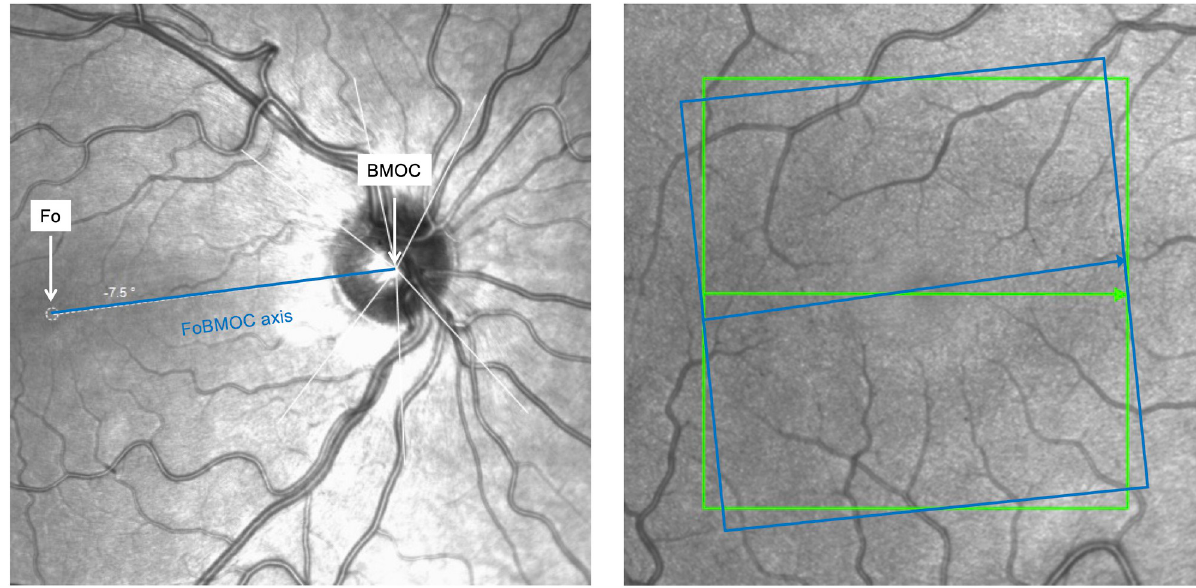
Fig 2. OCT-A scan window of macula region without (green box) and after (blue box) aligning according to the fovea (Fo) to Bruch’s membrane opening center (BMOC) axis (FoBMOC axis).